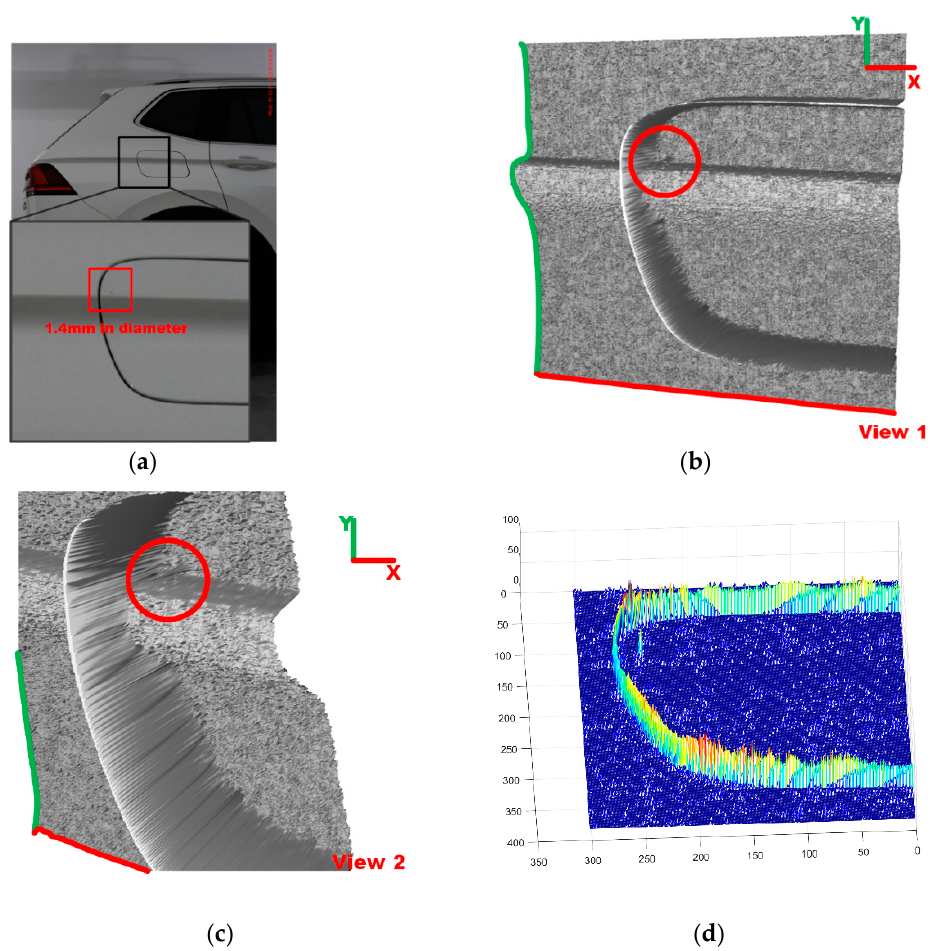
Figure 9. Case study: evaluation of the proposed algorithm dealing with a defect close to fuel tank cap ( a ) Detection region on fuel tank cap; ( b ) 3D representation of the magnified region (view1); ( c ) 3D representation of the magnified region (view2); ( d ) 3D map of λ 1 in DBHM. With a global threshold (T = 16) set by the binarization filter in Equations (8) and (9), we can